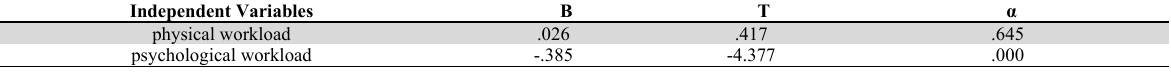
Results of Multiple Regression Analysis between Workload and Cyberloafing Independent Variables